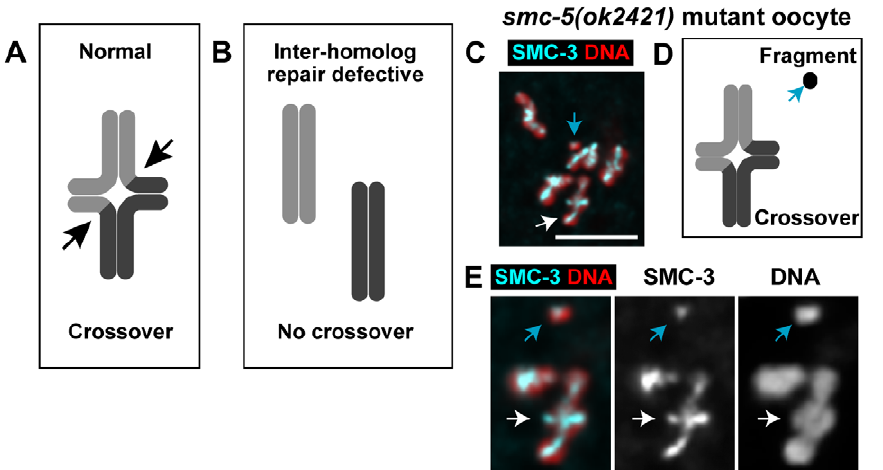
Figure 5. Chromosome fragmentation defects in smc-5 and smc-6 mutant diakinesis oocytes that successfully formed crossovers. Cartoon representations (A and B) of a pair of homologous chromosomes at diakinesis. (A) In wild-type, inter-homolog association is maintained by cohesion between the recombinant chromatids. The location of the chromatid exchange is indicated by the two black arrows, which provides the focal point for the restructuring of chromatid axes that results in a ‘‘cross-shape’’ or cruciform structure of the diakinesis chromosomes in C. elegans [67]. (B) If inter-homolog crossover failed to form, the homologous chromosomes would prematurely separate and the chromosome axes will not have the cruciform shape. (C) Micrograph of an smc-5(ok2421) mutant oocyte containing six linked homolog pairs with the wild-type cruciform shape, indicating successful inter-homolog crossover formation. Projection depth and scale bar=5 m m. (D) A cartoon representation of the linked homolog and DNA fragment shown in (C and E). (E) Magnified view of a linked homolog pair (white arrow) and a chromosome fragment (light blue arrow) from (C) for which cohesin SMC-3 staining also was detected on the fragment. Projection depth=2 m m.